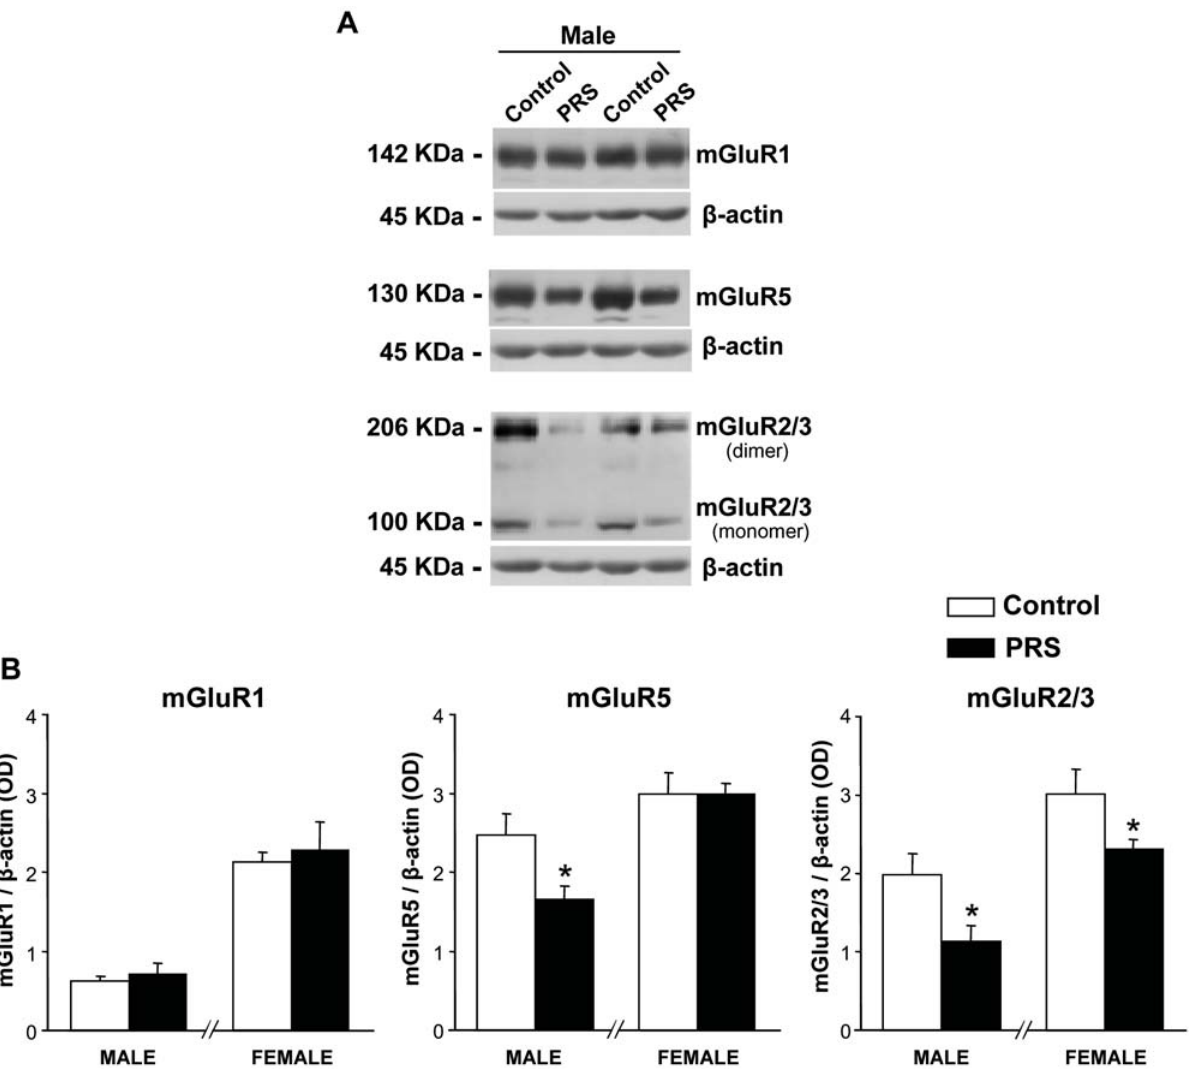
Figure 5. Expression of group-I and group–II mGlu receptors in the hippocampus of control and PRS rats. (A) Immunoblots with mGlu1a and mGlu5 receptor antibodies showed a 142 kDa and 130 kDa bands, respectively, corresponding to receptor monomers. No bands of higher molecular weight were detected under our experimental conditions. Blots with antibodies recognizing an epitope common to mGlu2 and mGlu3 receptors showed a 100 kDa band corresponding to receptor monomer(s), and a higher molecular weight band (206 kDa), which may correspond to receptor dimers. (B) In male rats, PRS induced a reduction in the expression of mGlu5 receptors (* p , 0.05, ANOVA: F (1,13) =7.22,) but no change in the expression of mGlu1a receptors. PRS had no effect on the expression of mGlu1a and mGlu5 receptors in female rats. Interestingly, PRS reduced mGlu 2/3 receptor expression in the hippocampus of both male and female rats (ANOVA: F (1,13) =6.62, p , 0.05 for males and F (1,13) =4.76, p , 0.05 for females). Male and female hippocampi were processed separately. Results are expressed as the ratio of the optical density (OD) of the mGluR1a, mGluR5 or mGlu2/3 band and the b -actin band. Values are expressed as means 6 S.E.M. (n=7 rats per